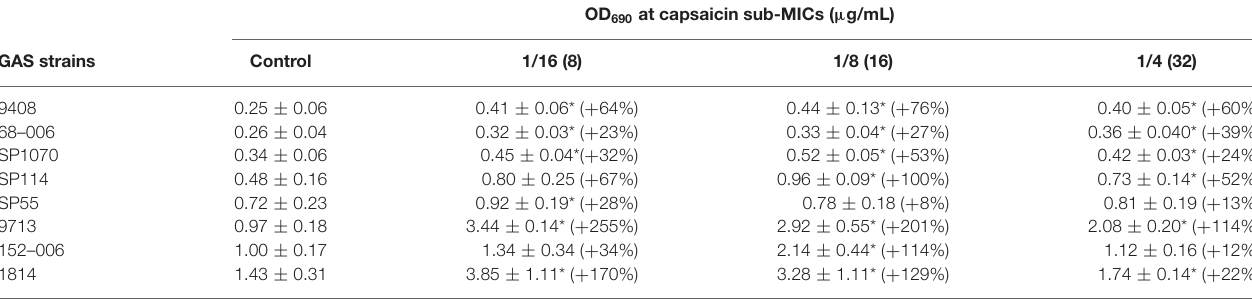
TABLE 1 | Biofilm production by test strains in presence of capsaicin sub-MICs.